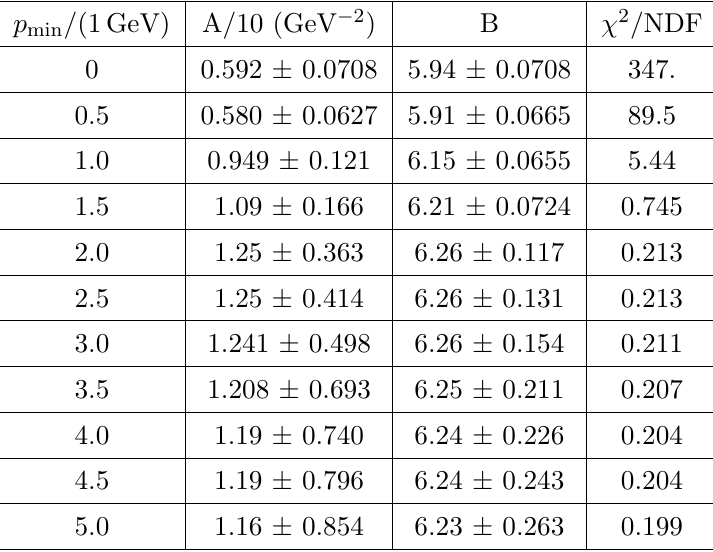
Table 10. Fitted values of parameters in eq. (E.2) for the ALICE dataset at p s = 5 : 02 TeV in the 1 : 3 < (cid:17) < 0 : 8 bin [95]. (cid:0) (cid:0)